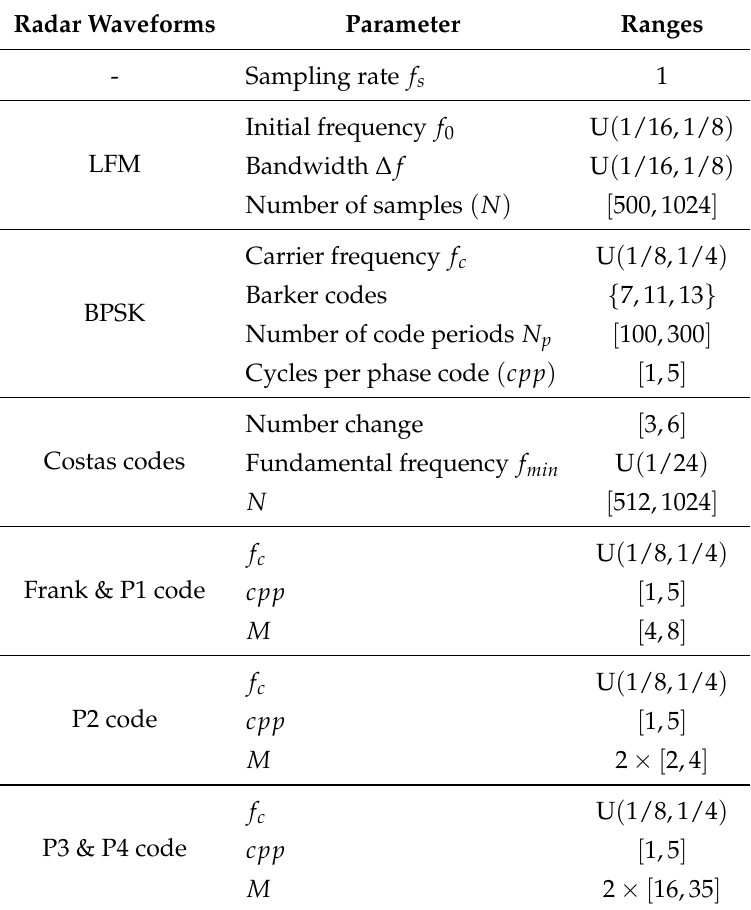
Table 2. List of simulation